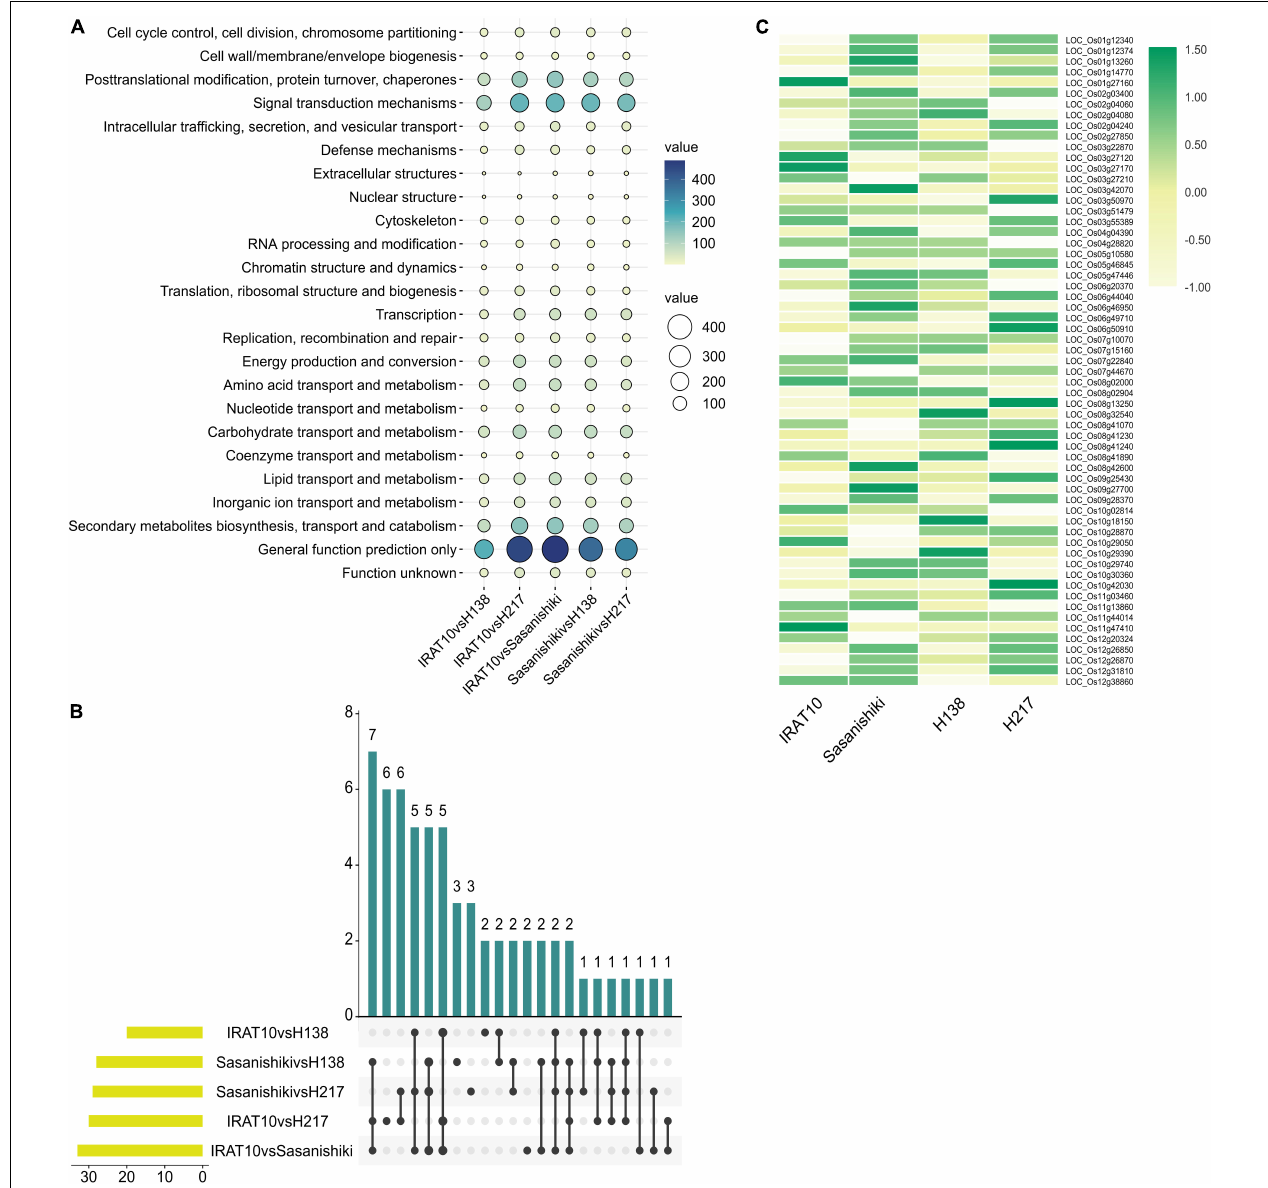
FIGURE 7 | Transcriptional analysis of flag leaves among tested varieties at heading stage. KOG function classification of differentially expressed genes (A) . The number of differentially expressed genes from different pairwise comparisons in cell cycle classification (B) . Gene expression levels of genes related to cell cycle, cell division, and chromosome partitioning (C)